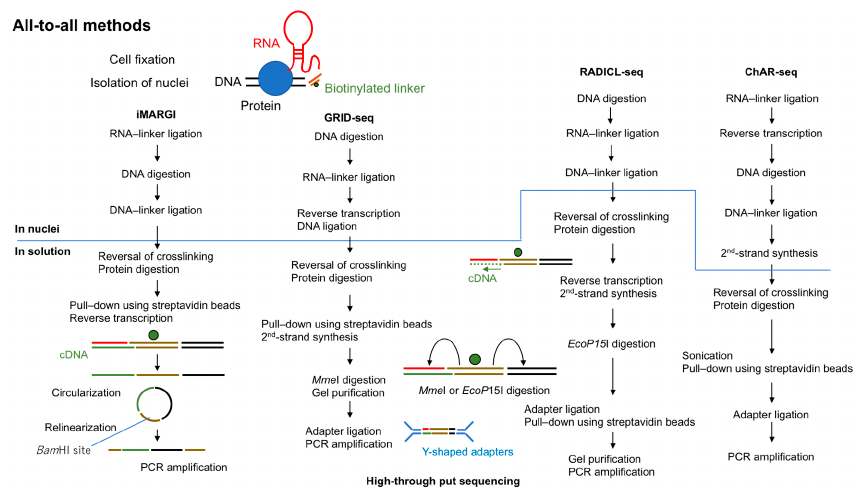
Figure 2. Overview of all-to-all methods to capture RNA-interacting genomic loci. All four methods (MARGI (mapping RNA–genome interactions), GRID-seq (global RNA interaction with DNA sequencing), RADICL-seq(RNAandDNAinteractingcomplexesligatedandsequenced), andChAR-seq (chromatin-associated RNA sequencing)) use fixed cells and biotinylated 5 (cid:48) -adenylated linkers. The steps above the line are performed in nuclei and those below the line are performed in